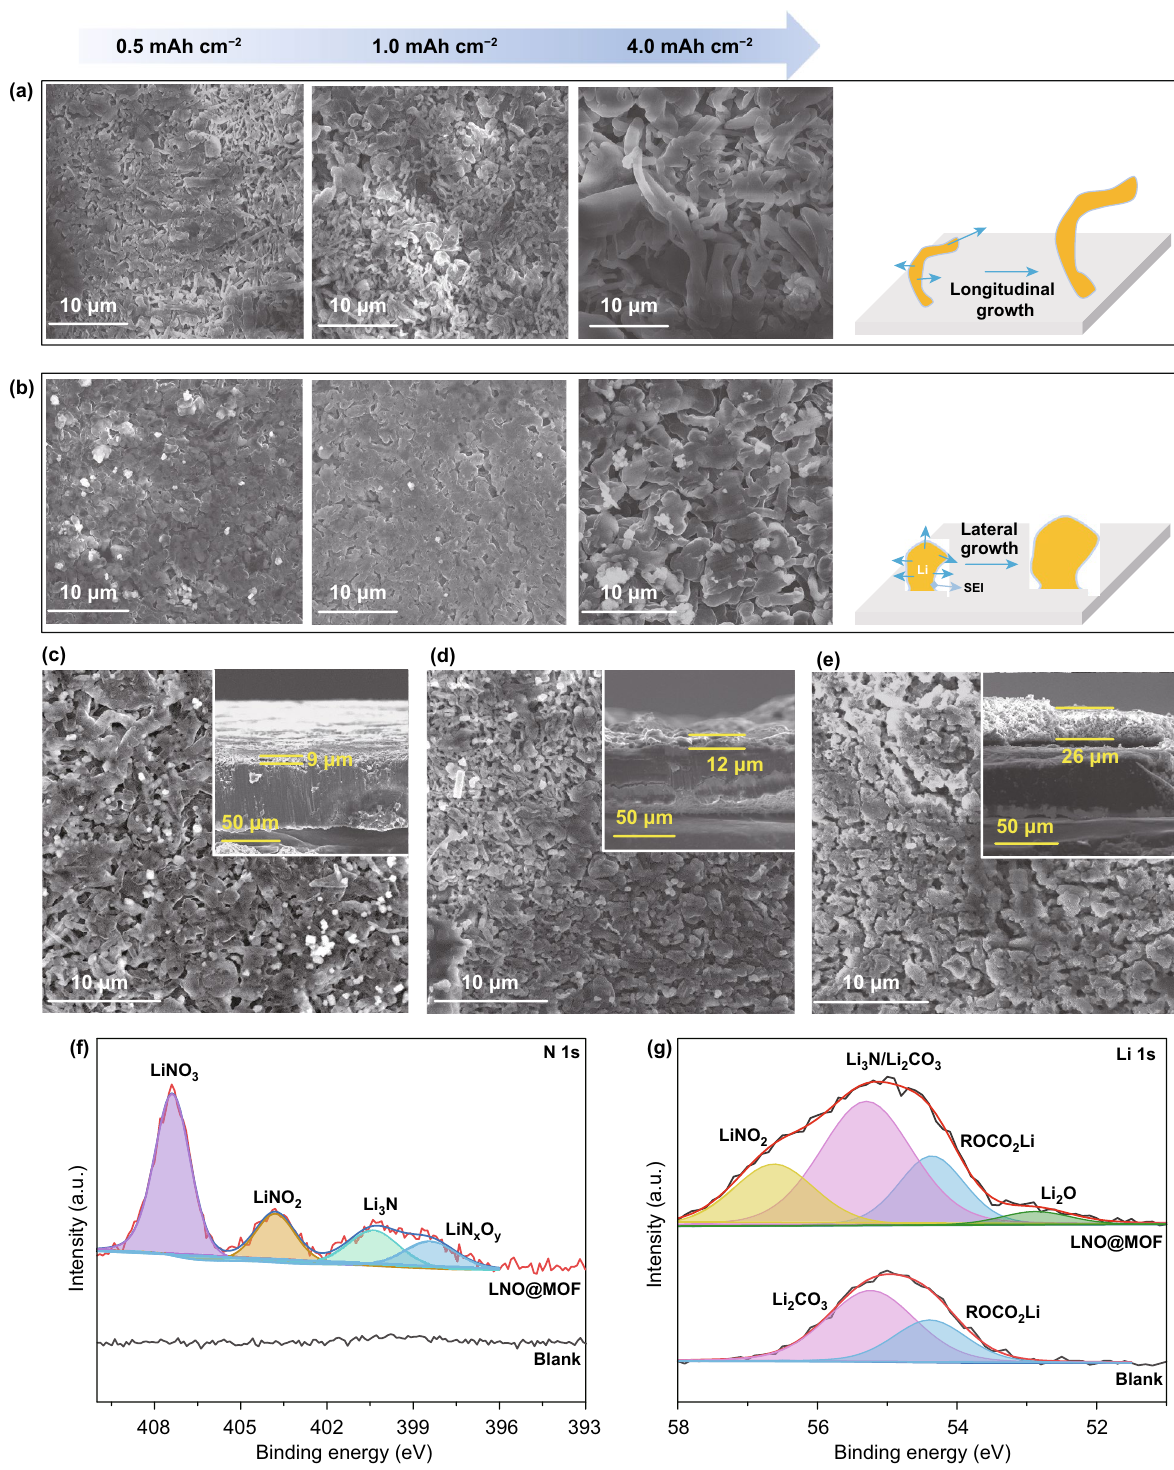
Fig. 3 SEM images of LMA after deposition of 0.5, 1 and 4.0 mAh cm −2 at 1 mA cm −2 with a blank electrolyte and b LNO@MOF electro- lyte. The surface and cross section images of the cycled LMA in LNO@MOF electrolyte after c 10 cycles, d 50 cycles, and e 100 cycles at 1 mA cm −2 and a capacity 1.0 mAh cm −2 (inset is the cross section view). XPS spectra of f N 1 s , g Li 1 s of the LMA with blank and LNO@ MOF electrolyte after 10